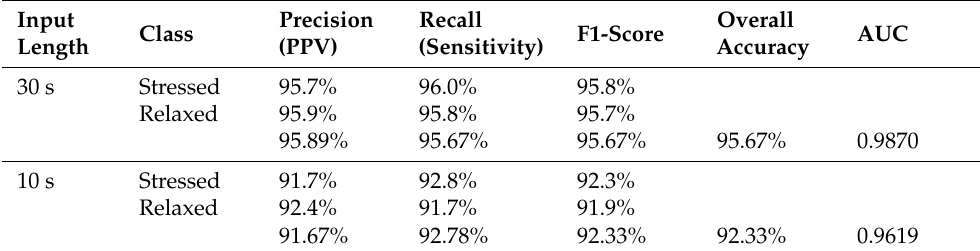
Table 4. Classification performance of proposed method based on input signal length.